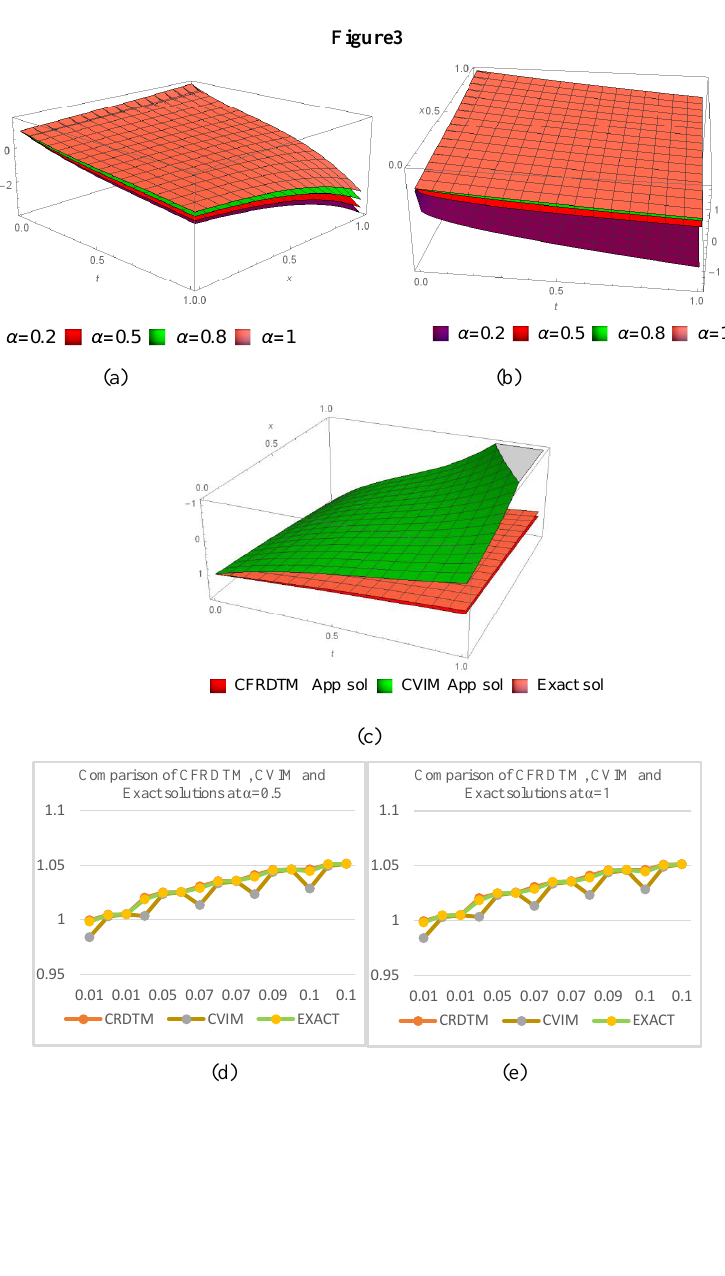
Figure 3: Approximate solution for the time-fractional Fornberg–Whitham Eq. (44) for different values of α with fixed values 0 ≤ t ≤ 1, 0 ≤ x ≤